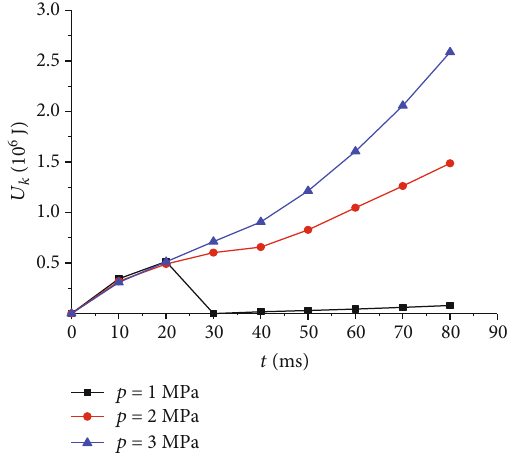
p = 1 , 2, k of the system with and 3